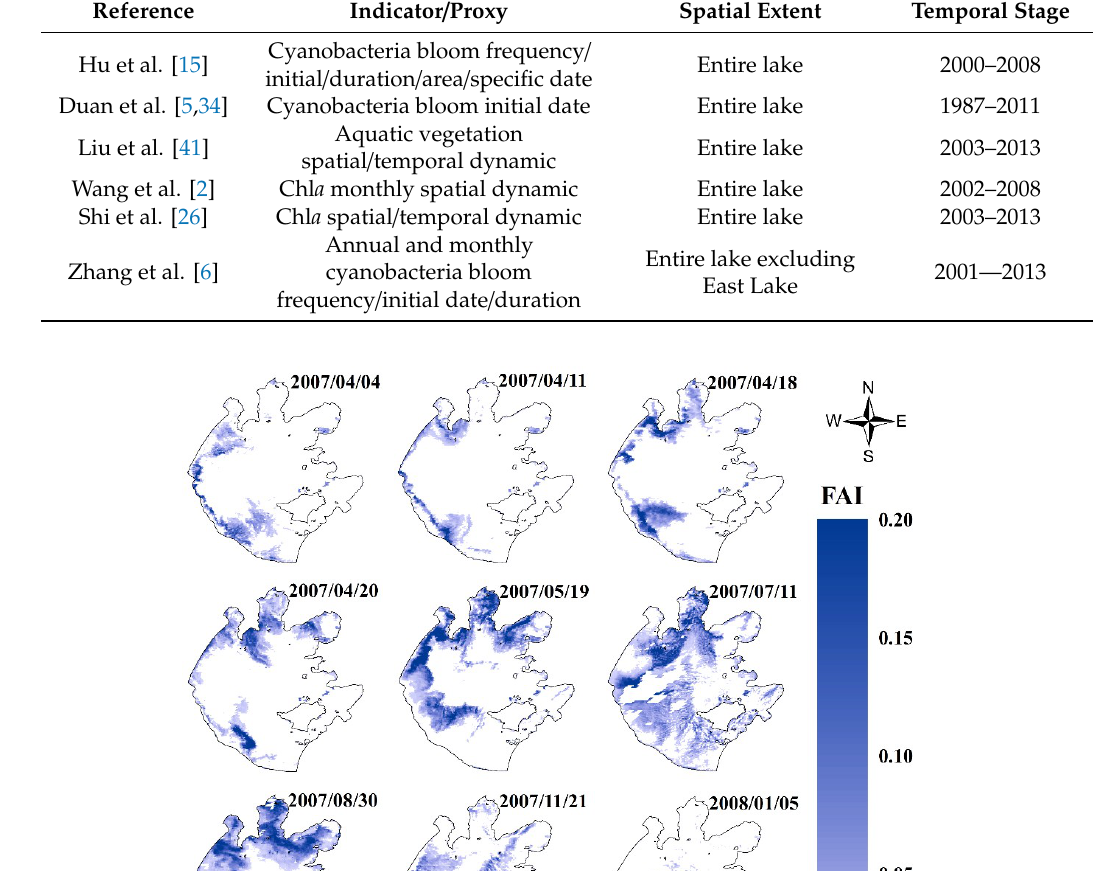
Table 3. Similar studies used for spatiotemporal pattern validation.